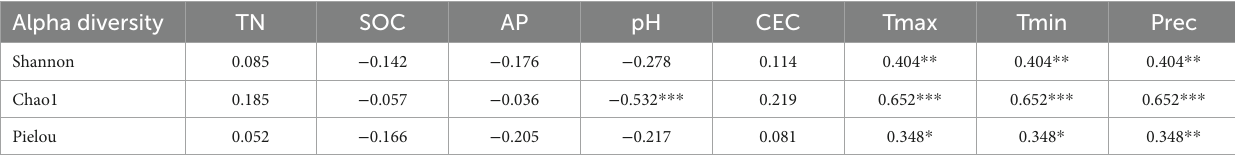
TABLE 2 Spearman correlation coefficient of alpha diversity to soil properties. Alpha